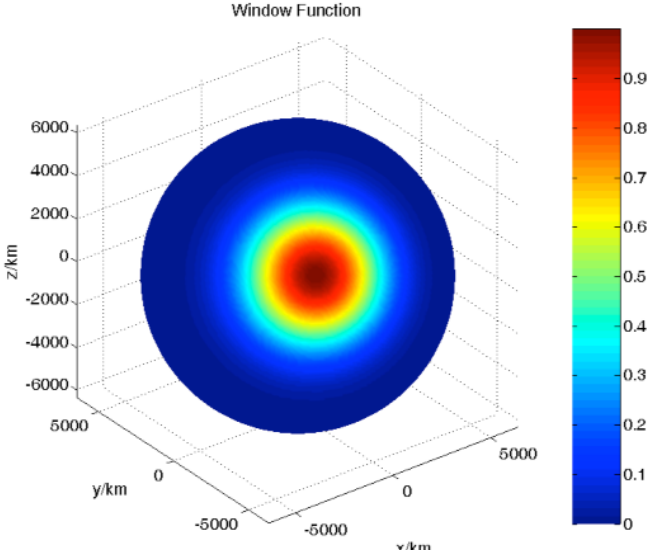
Figure 8. The window function with an attenuation factor p = 5 on the Earth surface.